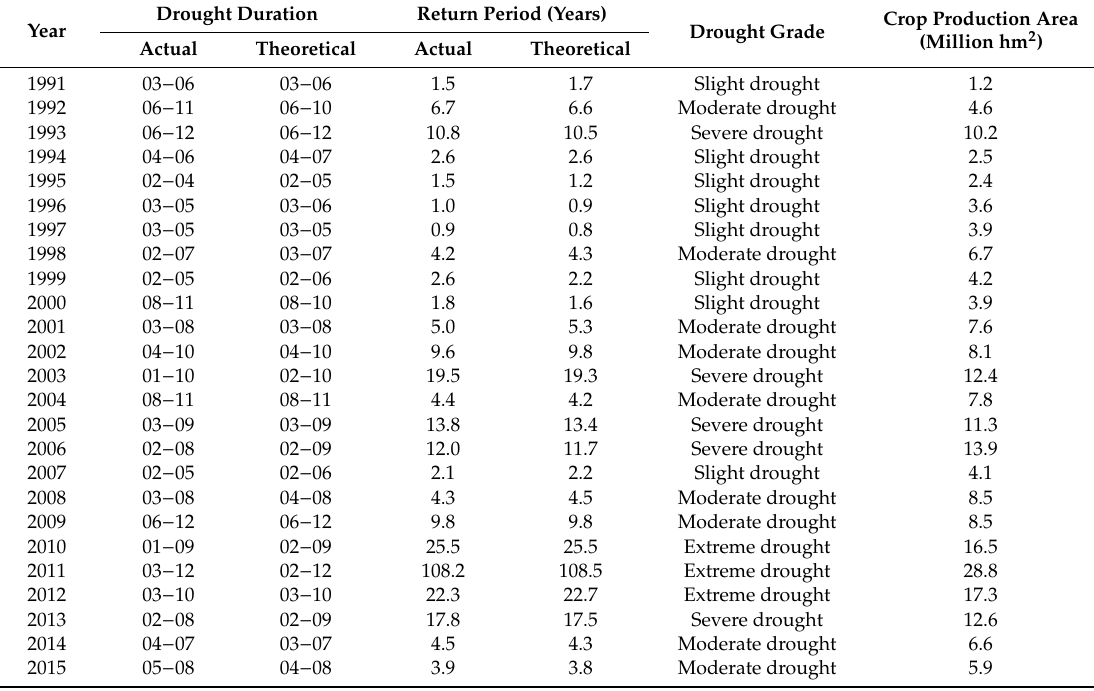
Table 6. Comparison of drought characteristics between theoretical and actual drought events in Zhaotong from 1991 to